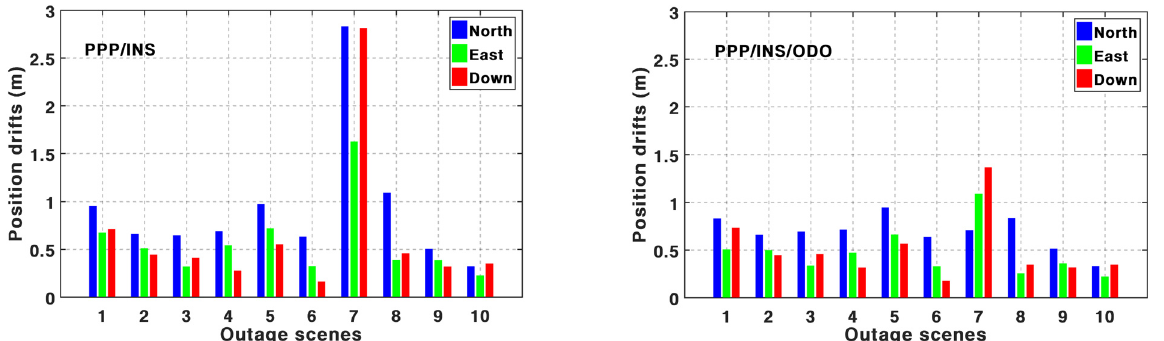
Figure 13. Positioning errors of BSSD PPP/INS/ODO TCI with frequent GNSS outages.